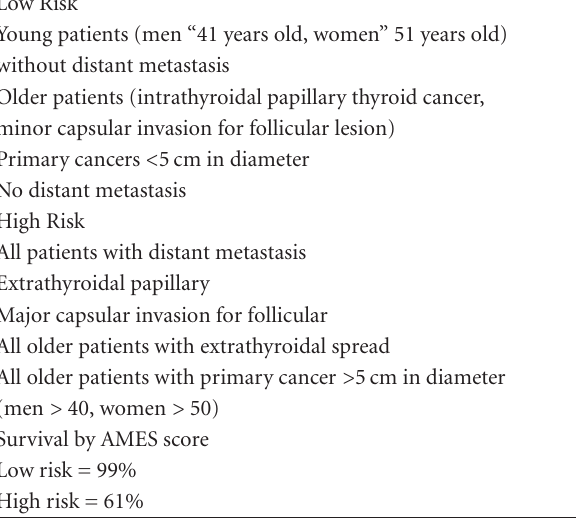
Table 3: AMES classification